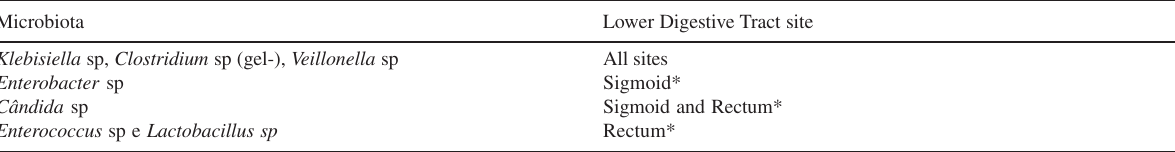
sp = species, * p < 0,05 or <